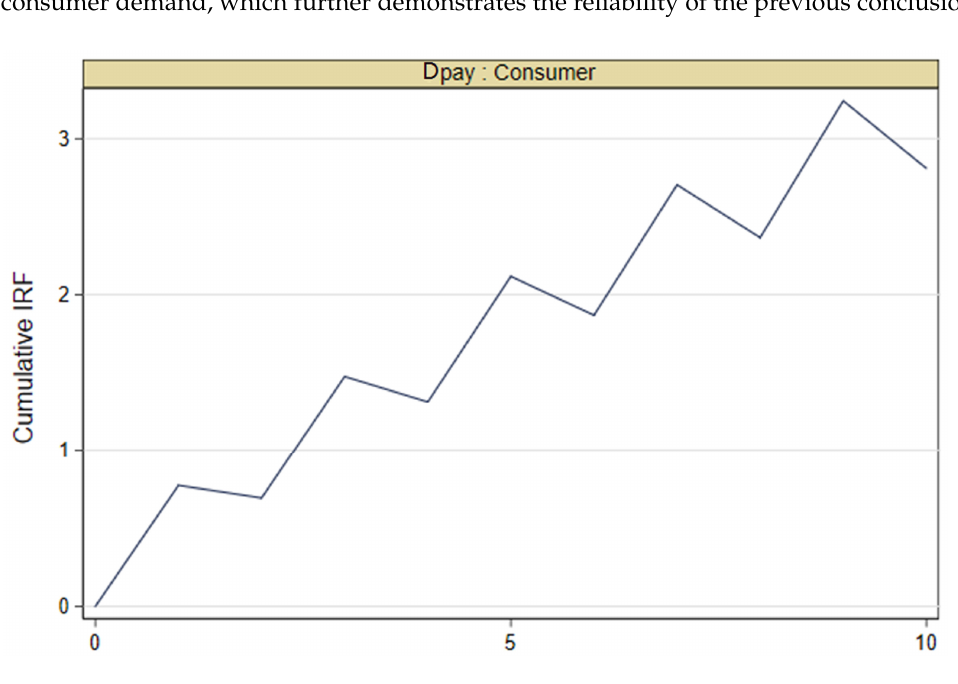
Figure 1. Pulse response